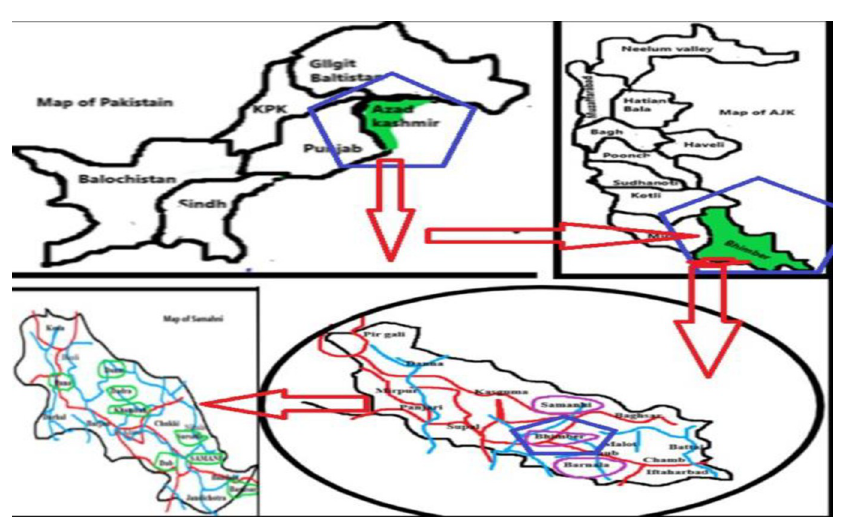
Fig 1. Map of study of Shiwalik mountaineous range of District Bhimber of Azad Jammu and Kashmir,